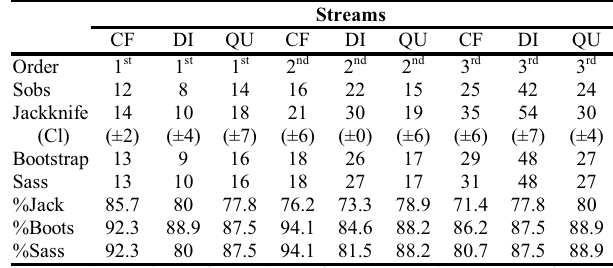
Table 3. Similarity values (Jaccard’s coefficient) of species composition among samples of 20-m reaches of 1 st , 2 nd , and 3 rd order stream segments located in the study areas of Biologi- cal Dynamics of Forest Fragments Project, Manaus, Amazonas State. General= mean values by stream order.